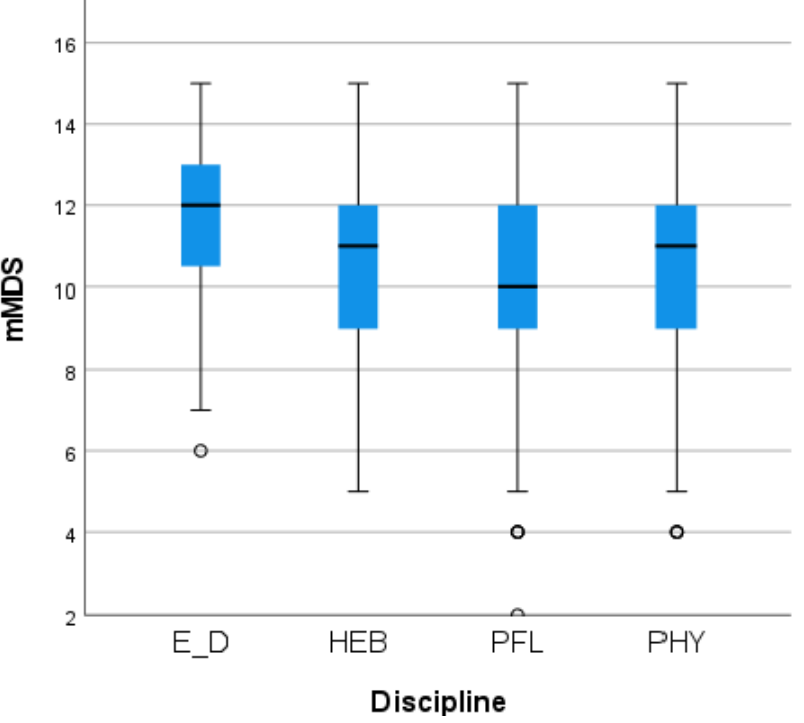
Figure 4. Box plots of the eating habits, measured using the modified Mediterranean Diet Score (mMDS), of students and employees (n=771) in each